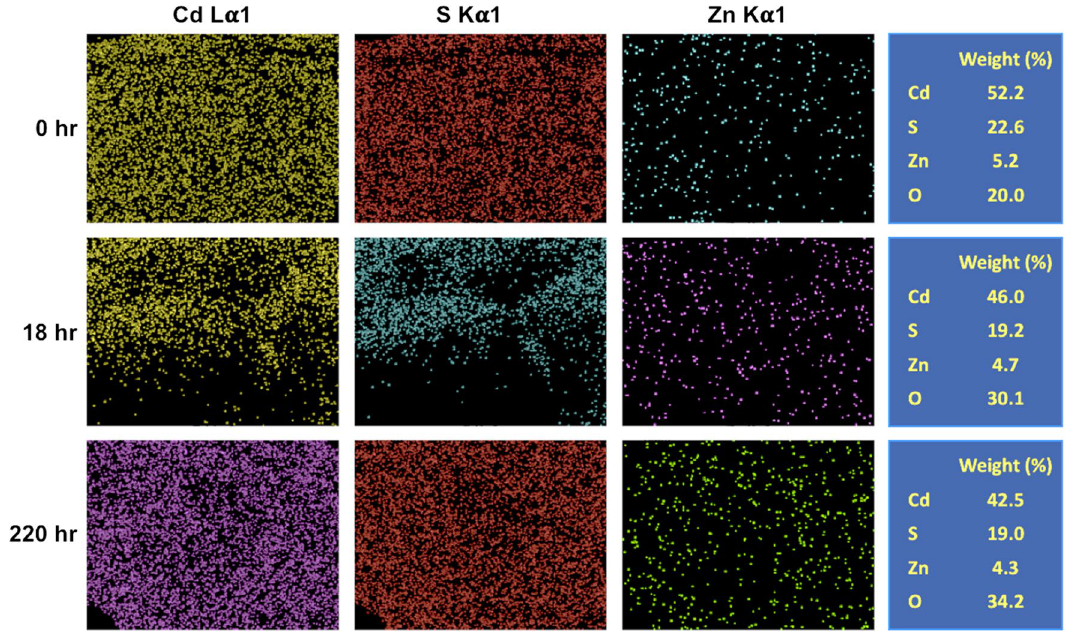
Figure 7. The EDS mapping and element composition of QDs versus test time tested under ambient condition. (Accelerating voltage = 10 kV, working distance = 5.7